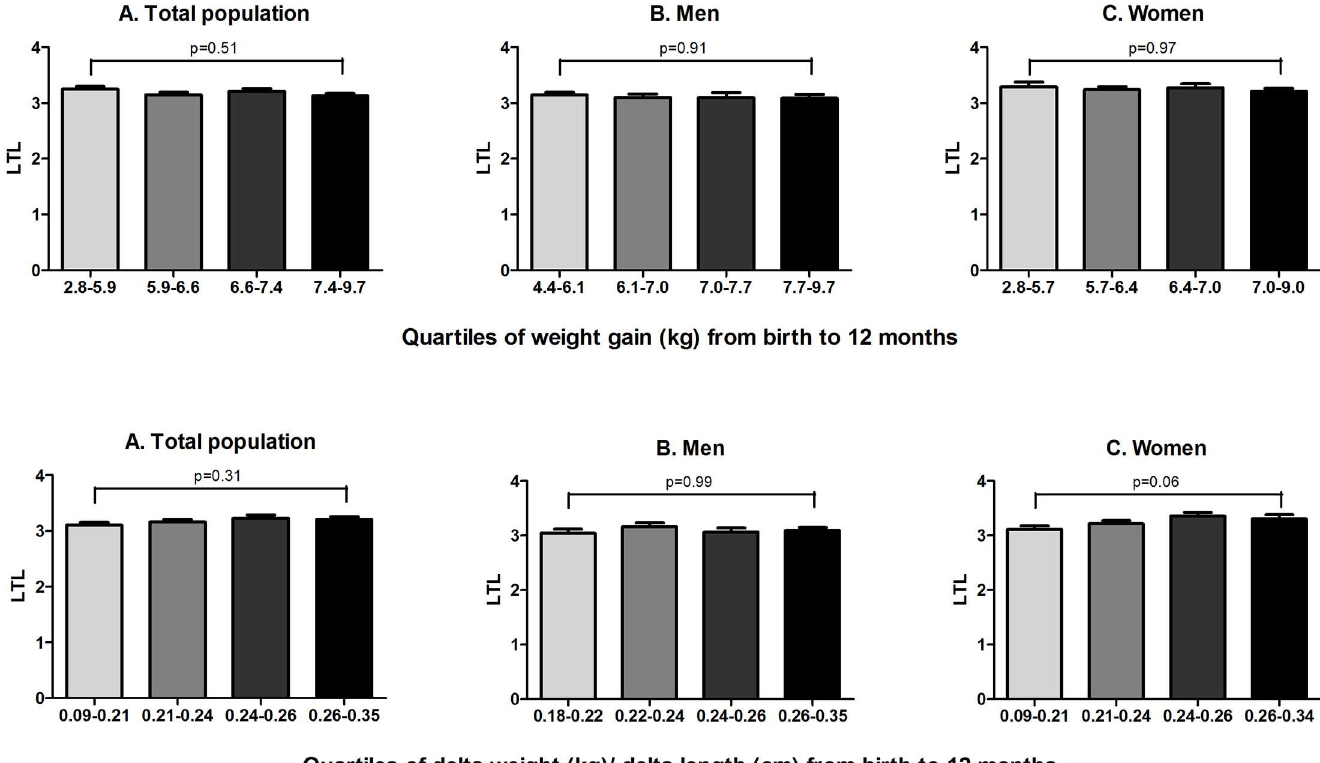
Fig 1. Weight gain and fat mass accumulation during infancy and LTL. Values are given as estimated means ± SEM, adjustedfor age and gestational